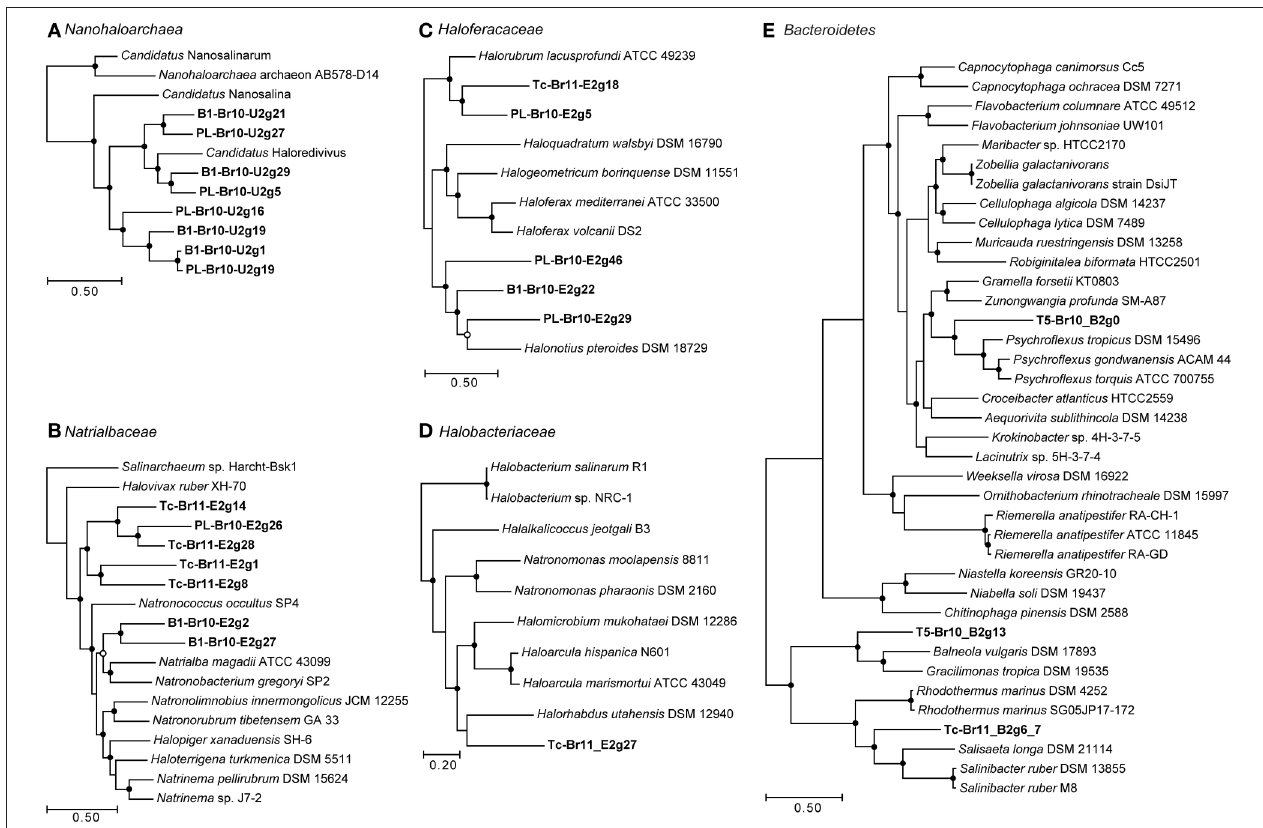
FIGURE 2 | Maximum-likelihood phylogenetic trees based on shared concatenated COGs between draft genomes reconstructed from the metagenomes and (near-)complete reference genomes. Filled circles at the nodes represent bootstrap values (100x) of 90–100%, open circles of 80–90%. Bars indicate the amount of sequence difference. All outgroups were pruned from the trees. (A) 62 COGs shared between reconstructed draft genomes and reference genomes from Candidatus “Nanohaloarchaea.” Outgroup = Halobacteria ; (B) 142 COGs shared between reconstructed draft genomes and reference genomes from the family Natrialbaceae (class Halobacteria ). Outgroup = Archaeoglobi ; (C) 104 COGs shared between reconstructed draft genomes and reference genomes from the family Haloferacaceae (class Halobacteria ). Outgroup = Archaeoglobi ; (D) 427 COGs shared between the reconstructed genome Tc-Br11_E2g27 and reference genomes from the family Halobacteriaceae (class Halobacteria ). Outgroup = Archaeoglobi ; (E) 228 COGs shared between the Bacteroidetes -related reconstructs and genomes from Bacteroidetes Order II insertae sedis (family Rhodothermaceae ), Chitinophagaceae, and Flavobacteriaceae. Outgroup = Aquificae